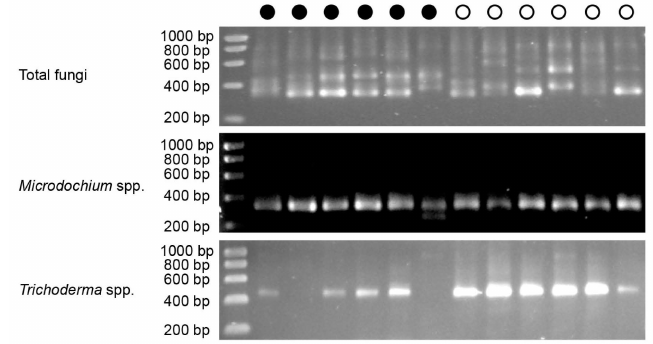
Figure 3. Detection of total fungi, Microdochium and Trichoderma in salmon egg samples by quantitative PCR. Total fungal community was detected using ITS4-ITS9 primers, Microdochium lycopodinum/Microdochium phragmitis species were detected by MPF-MPR primers, and Trichoderma species were detected by ITS1TrF-ITS4TrR primers. The concentration of DNA template of each sample was normalized at 5 ˘ 1 ng ¨ µ L ´ 1 . Closed and open circles indicate DNA samples extracted from Saprolegnia -infected (diseased) or healthy samples, respectively. The lane on the left is the size marker and the band size (bp) is indicated next to each